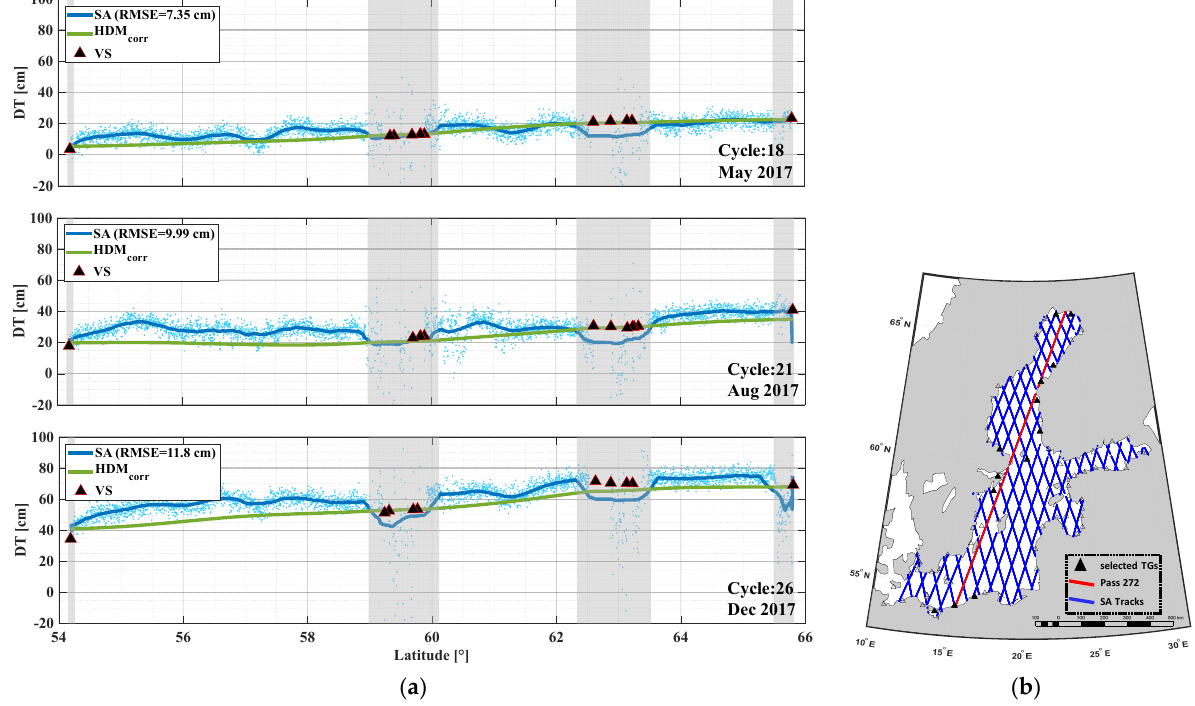
Figure 9. ( a ) Comparison of S3A pass #272 DT SA (blue dots) with the TG-corrected HDM ( DT HDM − corr ) (green line) for 3 cycles (representing different seasons) in 2017. The DT SA moving average is denoted by the blue solid line, the grey zones showing masked near coast and land areas, and the triangles denote locations of virtual stations; ( b ) the location of the S3A pass #272 in the Baltic Sea.